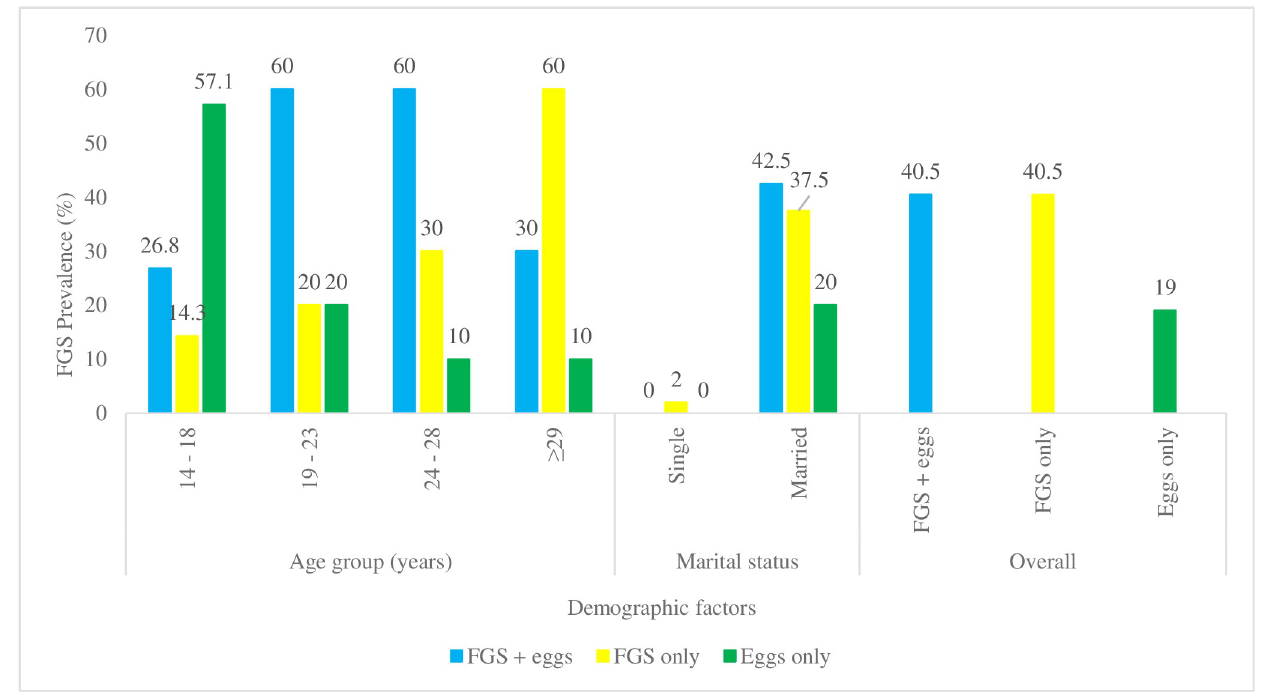
Fig 3. Categories of infection with respect to age and marital